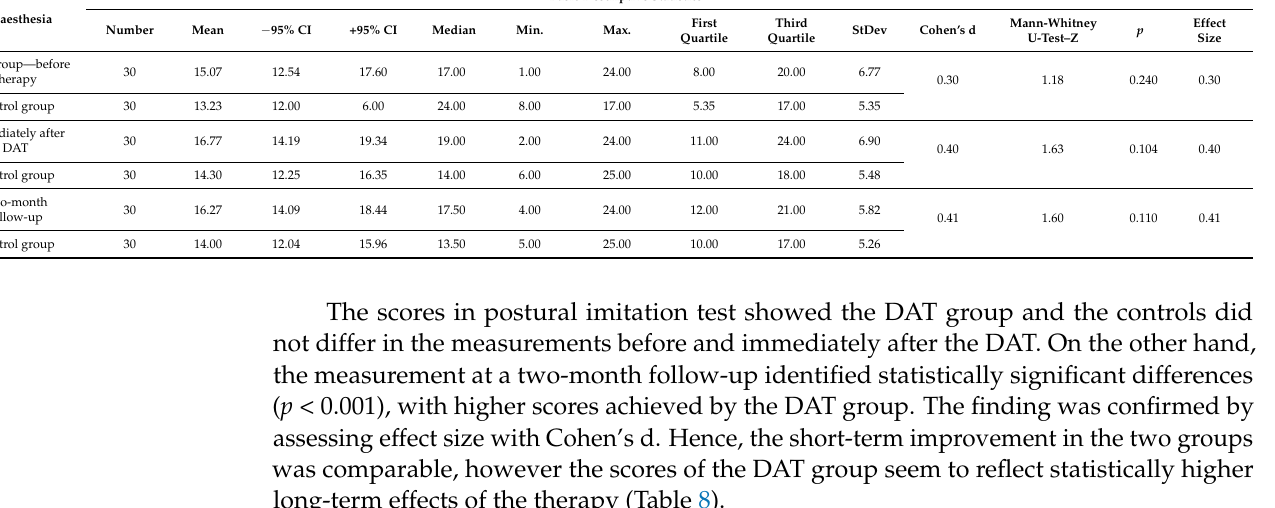
Table 7. Kinaesthesia—comparison of DAT group scores achieved over time to the results of the controls. Kinaesthesia